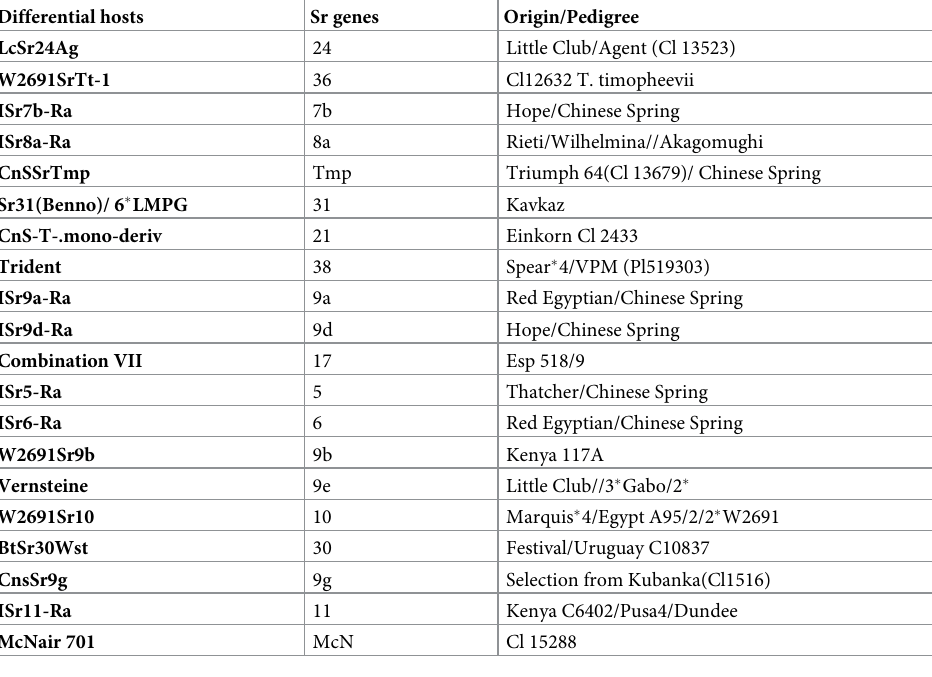
Table 1. List of twenty wheat differential hosts for stem rust with their corresponding Sr genes and origin/ pedigree. Differential hosts Sr genes Origin/Pedigree LcSr24Ag